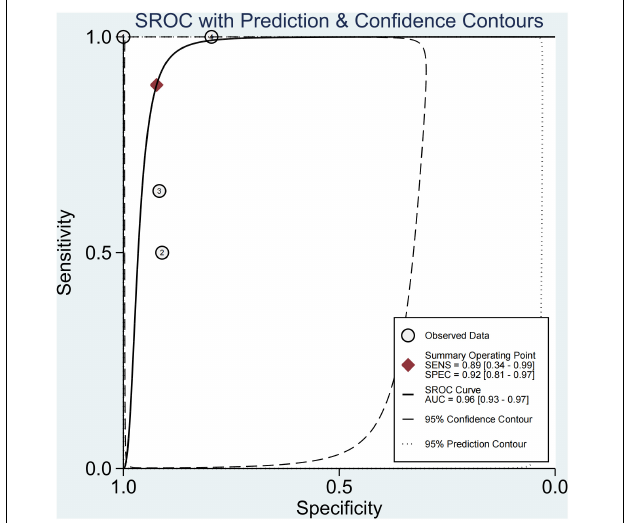
FIGURE 12 | Summary ROC curve of diagnostic performance of image techniques for steatosis.